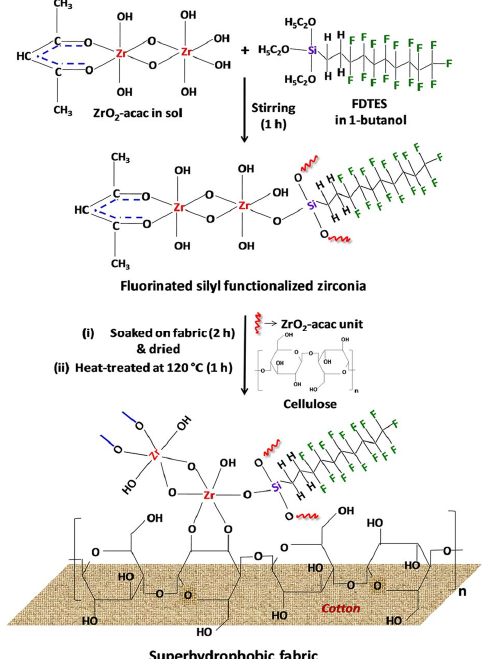
Figure 14. Schematic representation of fluorinated silyl functionalized zirconia sol-gel coated fabric (Reproduced from [137], under a Creative Commons Attribution 4.0 International License).